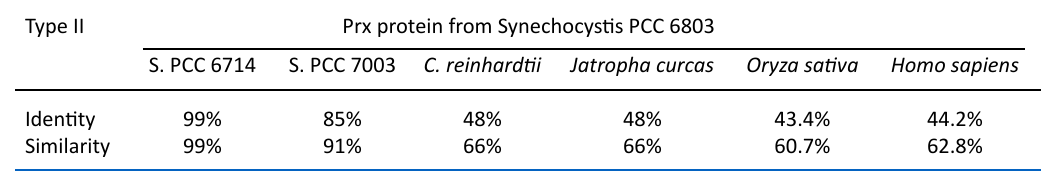
Table 1. Identity and similarity percent of type II Peroxiredoxin proteins of Synechocystis PCC 6803 with other type II peroxiredoxin